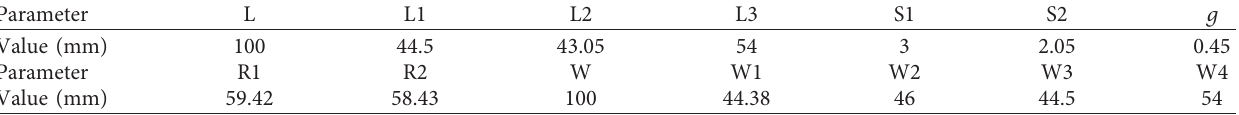
Table 1: Dimensions of the proposed odd function symmetrical equilateral right triangle slot broadband